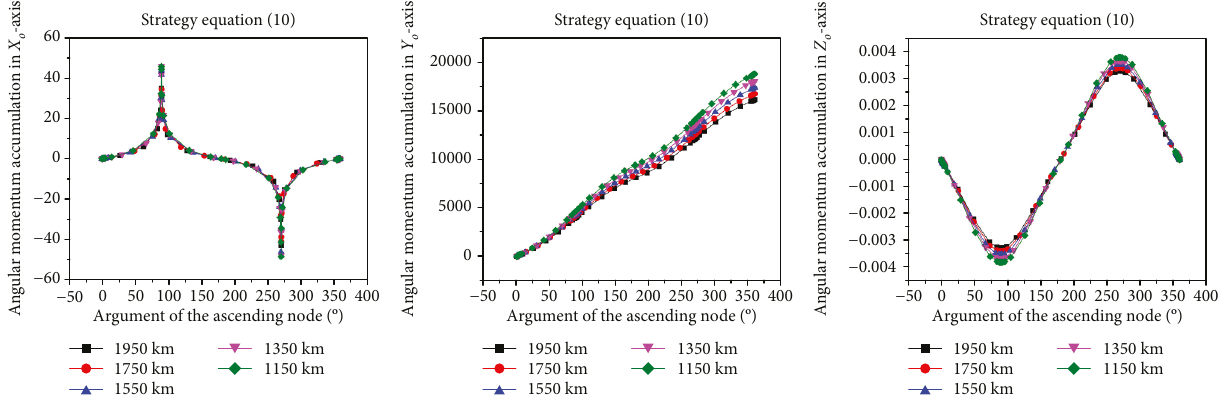
Figure 11: Angular momentum accumulation in the circular orbit (90 ° ) with di ff erent altitudes under equation (10) (example